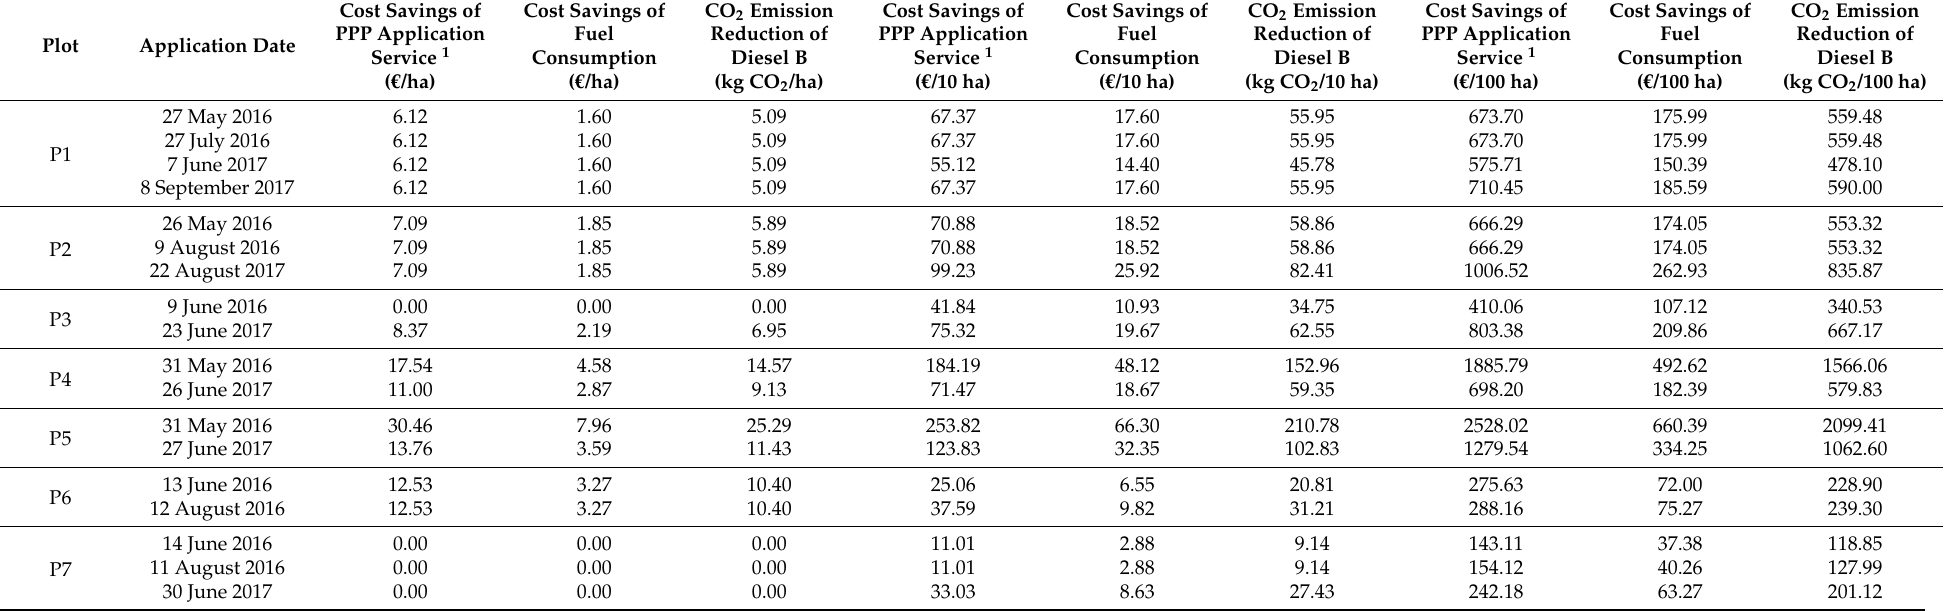
Table 5. Economic and environmental advantages per each orchard with CitrusVol for each spray application for 1, 10 and 100